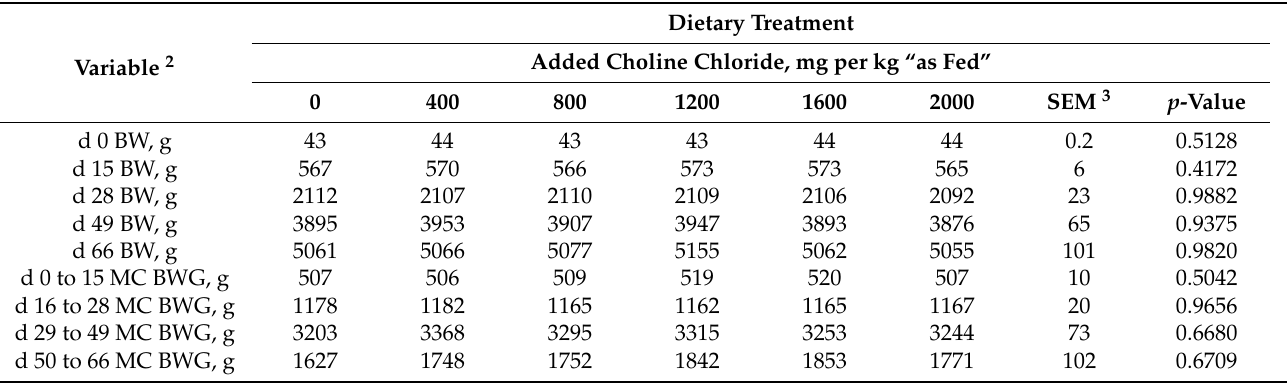
Table 3. Effects of choline chloride supplementation on broiler growth performance from 0 to 66 d 1